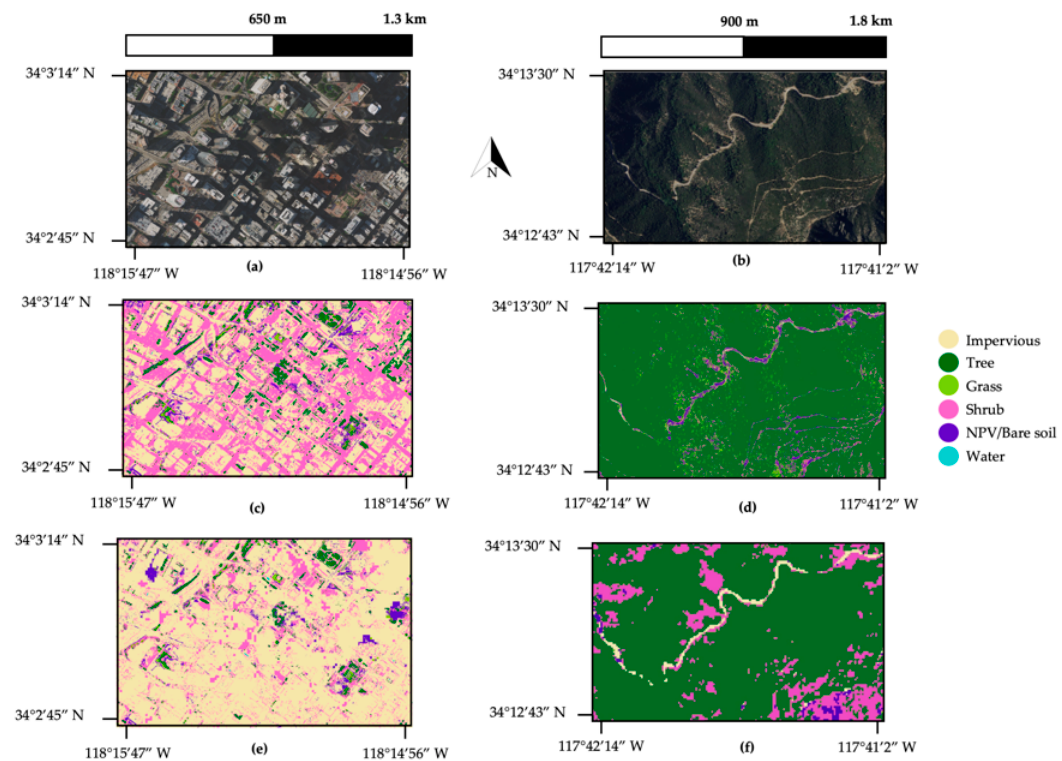
Figure 8. Our combined classification of median-derived Sentinel-2 and NAIP imagery in urban and non-urban areas significantly reduced misclassifications due to shadow e ff ects. NAIP imagery is not ortho-corrected and shows strong shadows in ( a ) heavily developed downtown Los Angeles, California and ( b ) Angeles National Forest. Our preliminary NAIP-only classification performed poorly in these regions, strongly overclassifying impervious surface as shrub in urban regions ( c ) and misclassifying shrub and forest as water and impervious surface in mountainous regions ( d ). Reclassifying urban areas that classified as “shadow” from our NAIP classification using median-derived Sentinel-2 imagery significantly reduced the number of impervious surface pixels that misclassified as shrub ( e ). All non-urban areas were classified with Sentinel-2 imagery in the final product, significantly reducing topographic shadow e ff ects and reducing the “salt and pepper” classification problem ( f ).